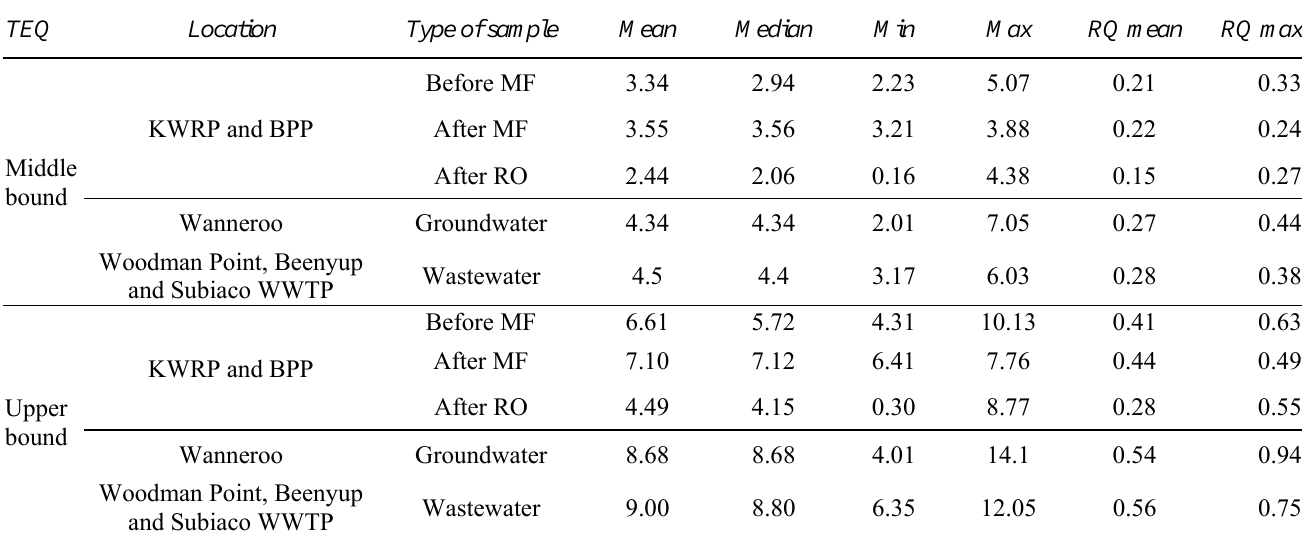
Table 3: Middle and upper bound TEQ (pg/L) by location TEQ Location Type of sample Before MF KWRP and BPP Middle bound Wanneroo Groundwater Woodman Point, Beenyup and Subiaco